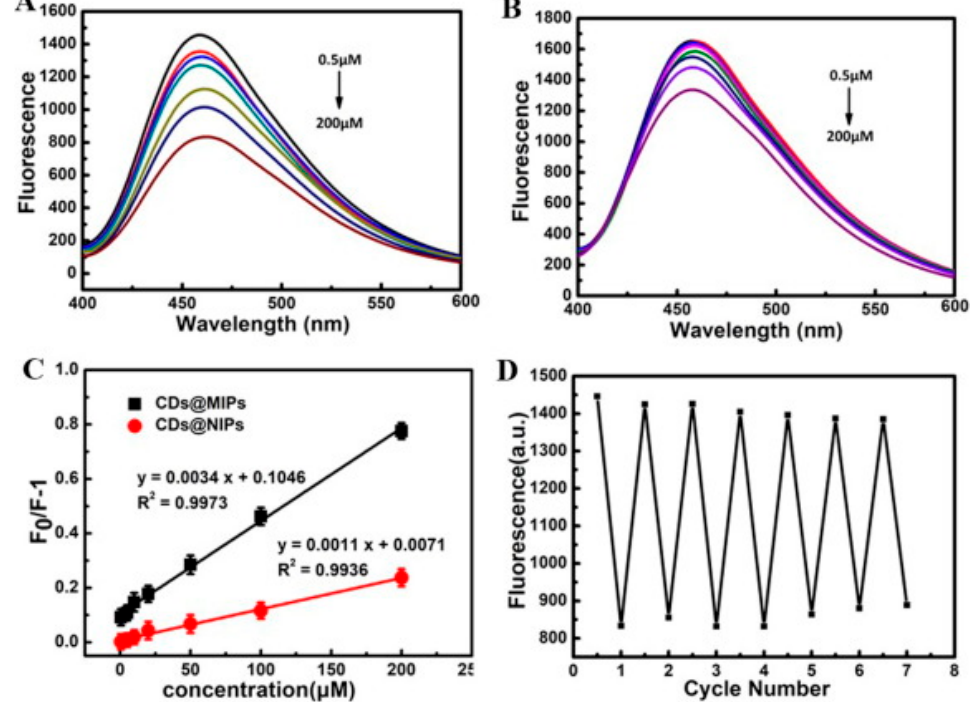
Figure 13. FL emission spectra of ( A ) CDs@MIPs and ( B ) CDs@NIPs after adding caffeic acid; ( C ) the linear correlation between the FL quenching efficiency of CDs@MIPs or CDs@NIPs and caffeic acid concentration; ( D ) reversible FL quenching and recovery cycles of CDs@MIPs upon the repeated removal (the bottom dots) and addition (the up dots) of caffeic acid. Reprinted with permission from [69]. Copyright (2018) Elsevier.